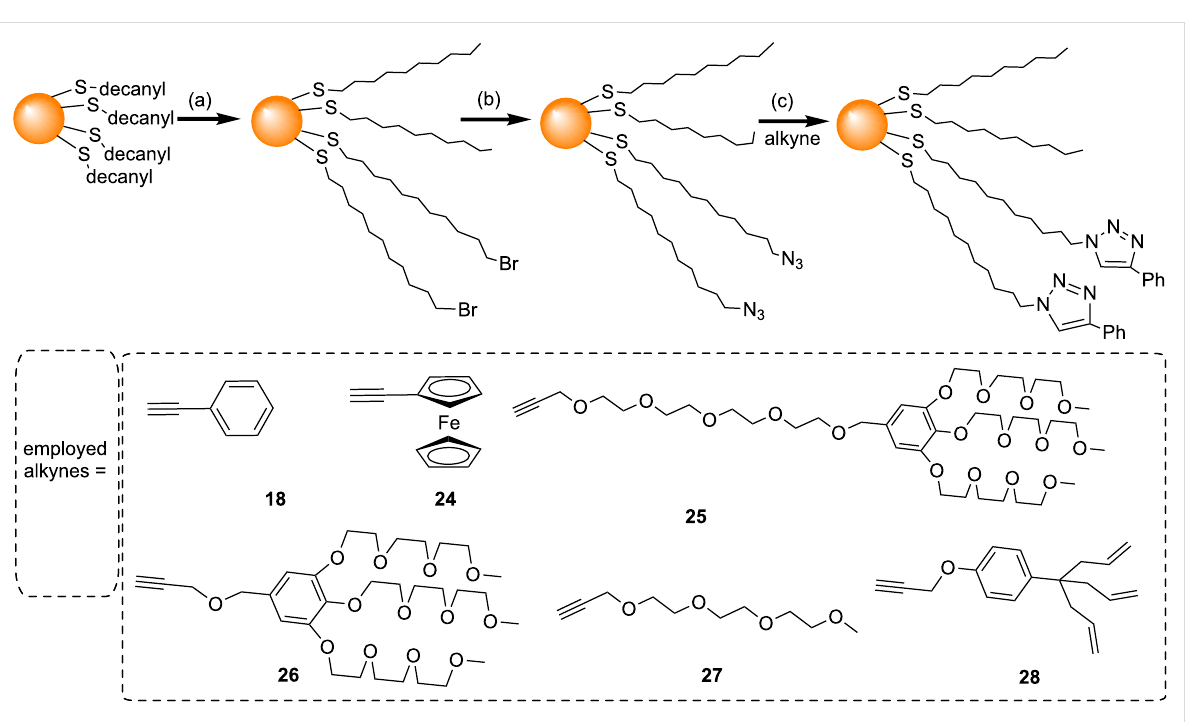
Scheme 9: AuNP functionalization and efficient CuAAC with a range of alkynes reported by Boisselier et al. [62]. Reagents and conditions: (a) HS(CH 2 ) 11 Br, DCM, rt, 5 d; (b) NaN 3 , DCM/DMSO, rt, 2 d; (c) CuSO 4 , sodium ascorbate, THF/H 2 O, 2 d, inert